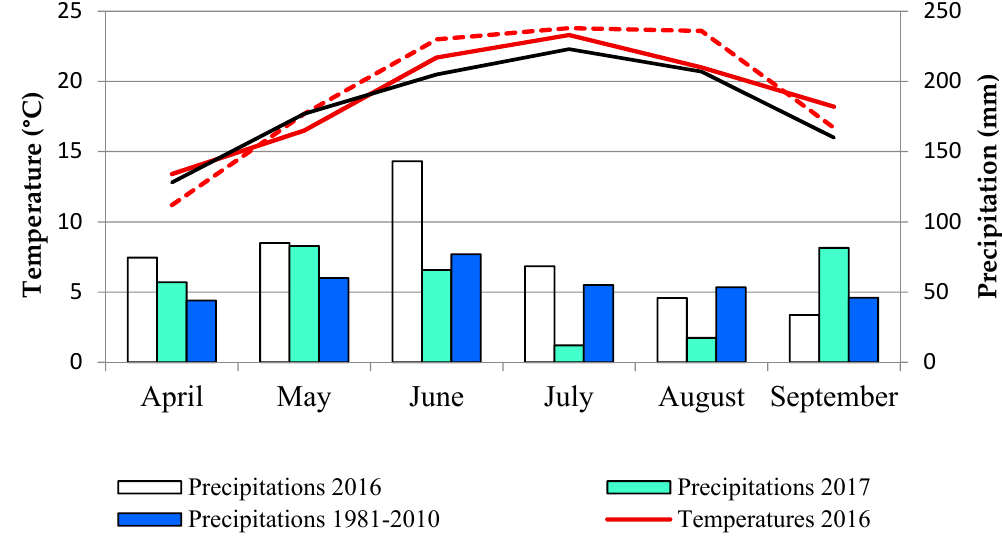
Figure 2. Meteorological data for study periods (2016–2017), location Futog, Vojvodina, Serbia.